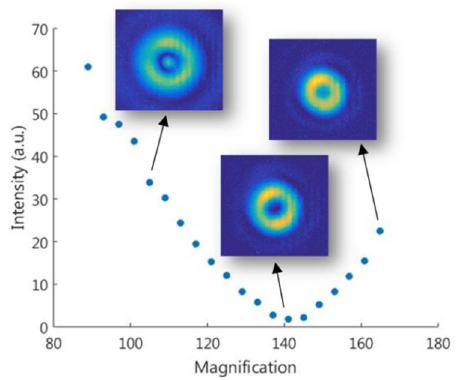
Figure 5. Measured intensity at the CCD 2 camera optical axis point as a function of the LP 02 mode magnification implemented in the SLM when illuminated with the LP 01 mode. Three measured transversal intensity distributions are superimposed for three specified points.